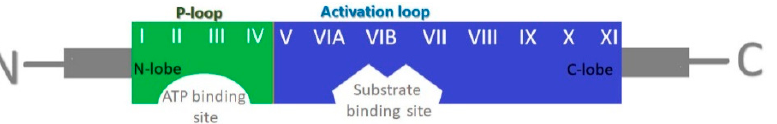
Figure 1. Protein kinase general structure. The N-terminal lobe (green) and the larger C-terminal lobe (blue) of the kinase are displayed in the figure. N-lobe includes the ATP binding pocket and the P-loop while activation loop and the Substrate Binding site are present in the C-lobe. The 12 conserved kinase subdomains (I, II, III, IV, V, VIA, VIB, VII, VIII, IX, X and XI) are also displayed.